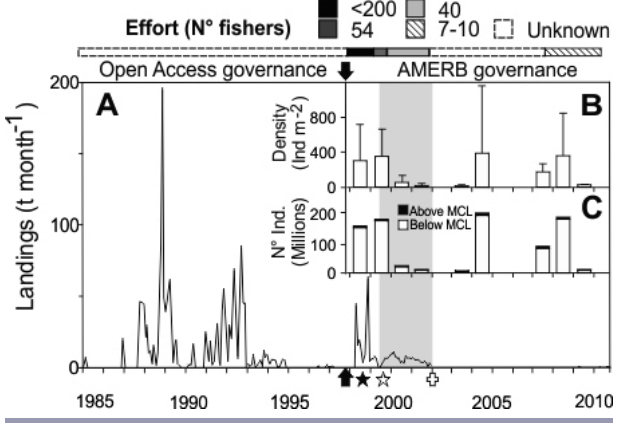
Fig. 2 . (A) Landings of surf clam (solid line) in open access and AMERB ((Management Areas for the Exploitation of Benthic Resources)) periods (main Y-axis). Symbols represent different milestones in Tongoy AMERB process (black arrows) Available area decree, (black star) ESBA (Estudio de Situación Base del Área) proposal, (white star) ESBA result and management plan for Undersecretary of Fishery report, (white cross) social- ecological system collapse. The gray zone in the main graph (A) represents the AMERB surf clam fishery with a quota regime. (B) Bar graph represents the surf clam density (ind. m-2) estimated in the AMERB direct assessments for the whole surf clam population, lines are the standard deviation. (C) Bars represent the total population estimated for the AMERB in each direct assessment. The white zone represents the population fraction below the Minimum Catch Length (MCL = 60 mm). The black zone of the bar represents the population fraction over MCL. The rectangle above the chart represents the effort (N° of fishers) during different periods in the surf clam fishery in Tongoy bay.